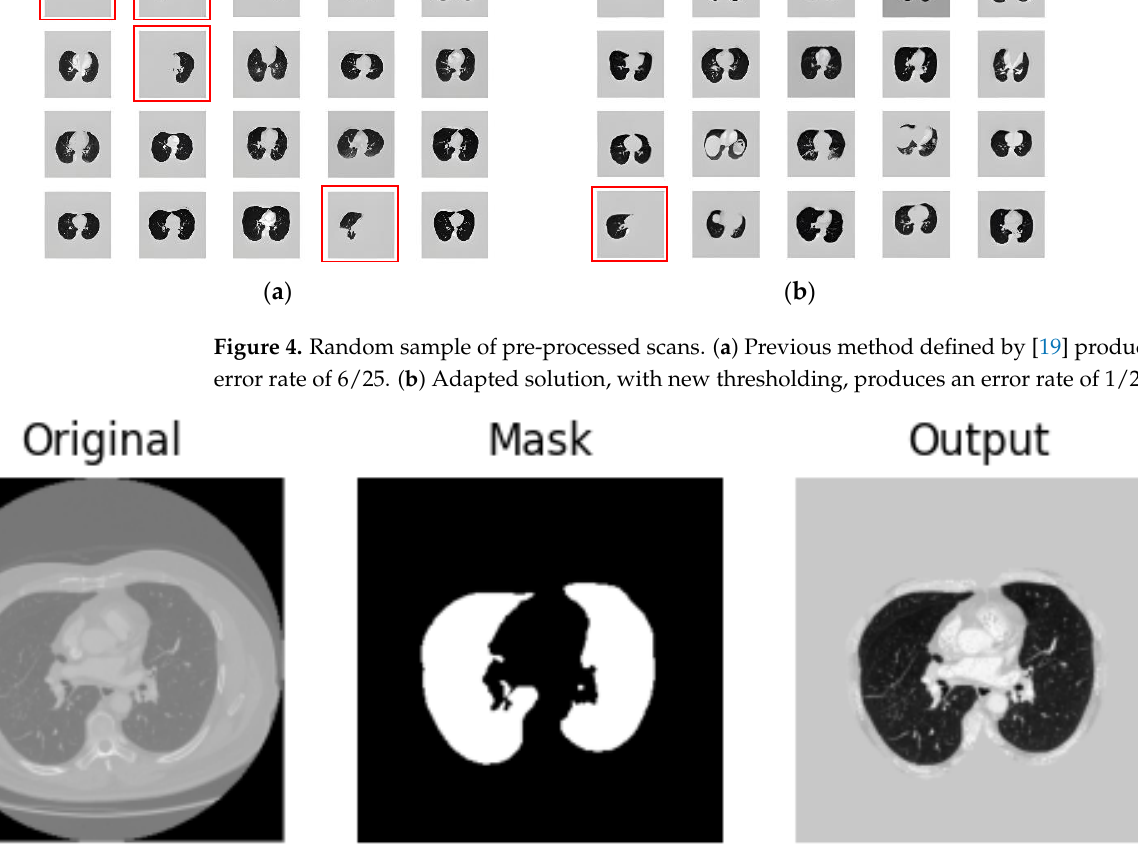
Figure 4. Random sample of pre-processed scans. ( a ) Previous method defined by [19] produces an error rate of 6/25. ( b ) Adapted solution, with new thresholding, produces an error rate of 1/25.